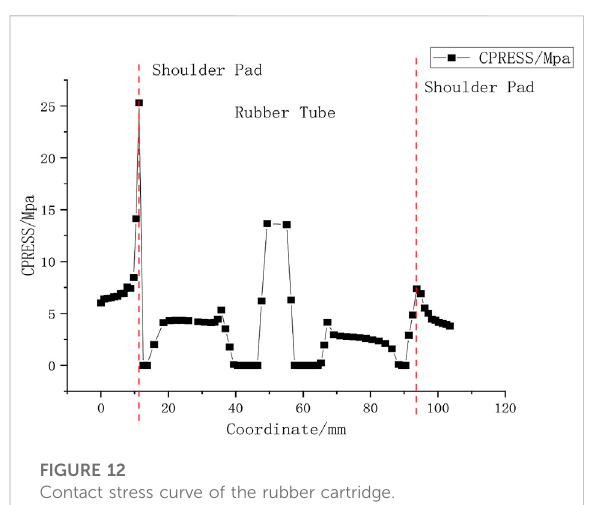
FIGURE 12 Contact stress curve of the rubber